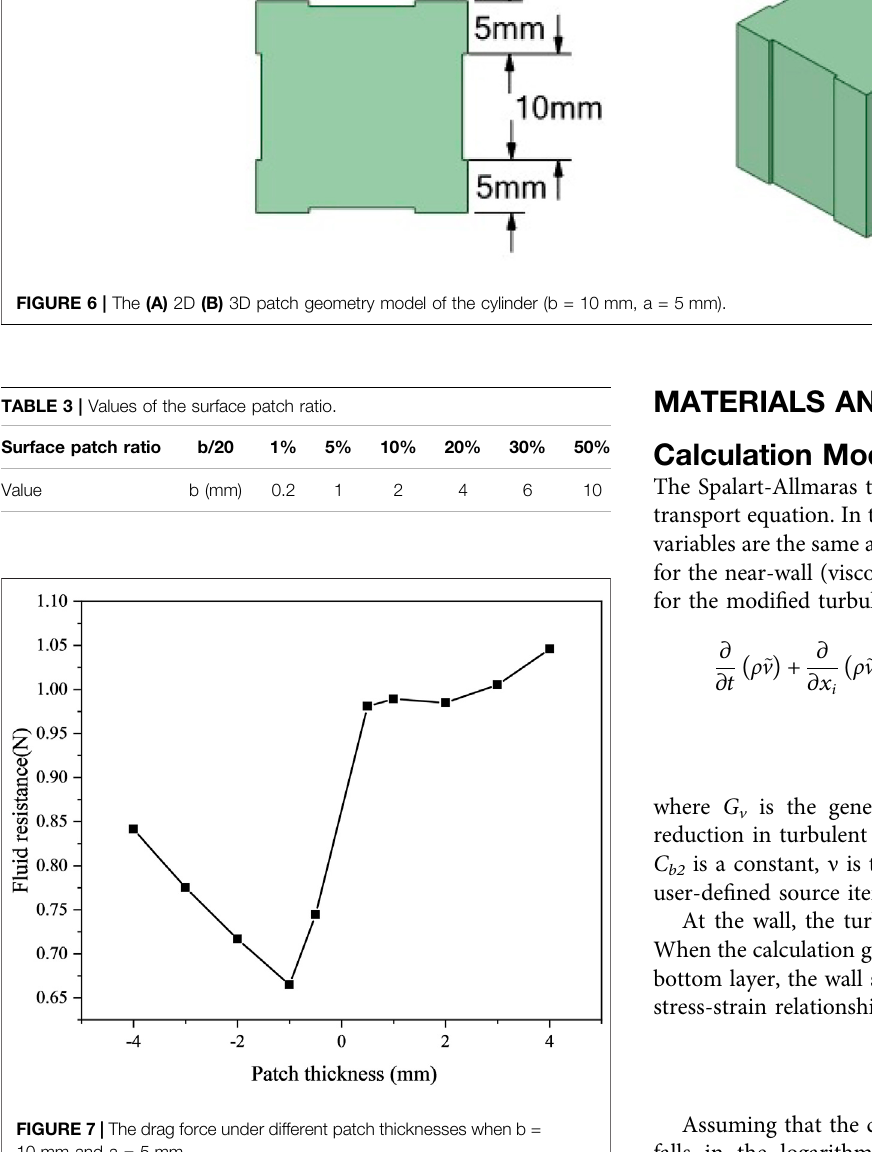
FIGURE 7 | The drag force under different patch thicknesses when b = 10 mm and a = 5 mm.